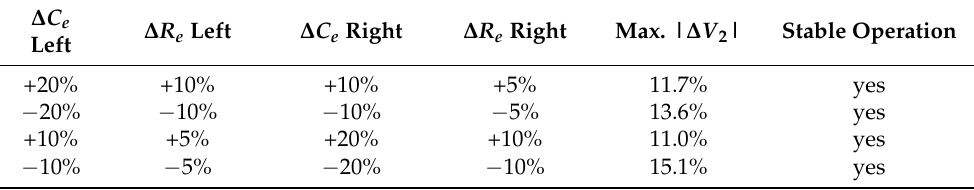
Table 7. Results of robustness analysis against variations of C e and R e in Scenario #1.